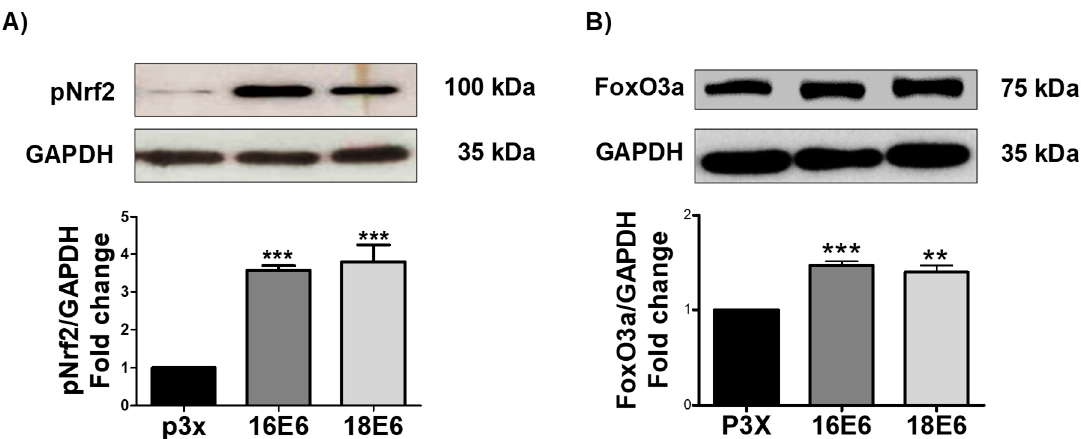
Figure 8. 16E6 and 18E6 oncoproteins increase pNrf2 and FoxO3a levels in FaDu cells. Representative immunoblot and quantitative densitometric analysis of ( A ) nuclear factor (erythroid-derived 2)-like 2 (Nrf2) phosphorylated in serine 40 (pNrf2); and, ( B ) forkhead box O3 (FoxO3a) in FaDu E6-transfected cells. GAPDH was used as a loading control. Data are expressed as the mean ± SD. Tukey’s test ** p < 0.005, and *** p < 0.0005 vs. p3X control, n = 3.